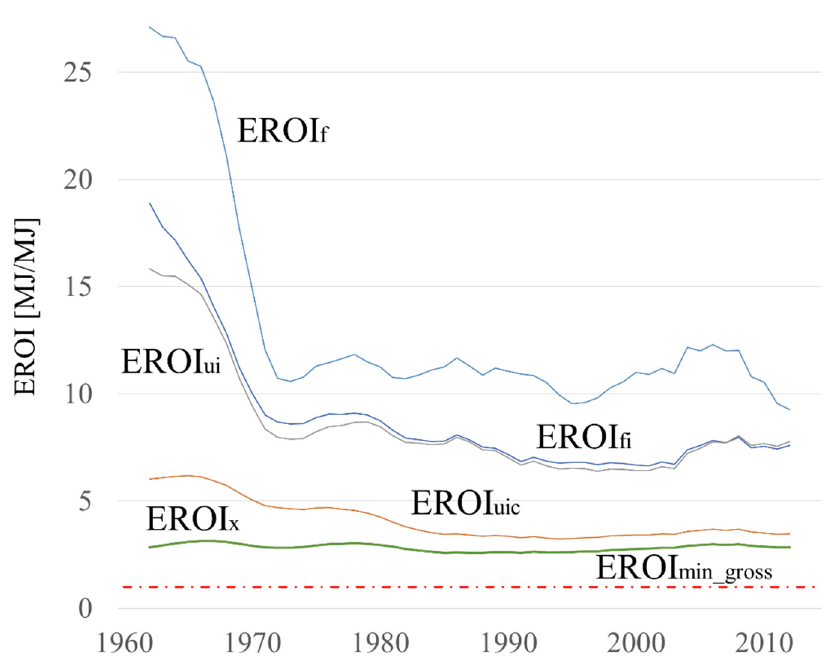
Figure 3. EROI estimates for Portugal between 1960 and 2014 (5 year moving averages; gross ratios). EROI f : final stage; EROI fi : final stage EROI considering costs related to energy imports; EROI ui : use-